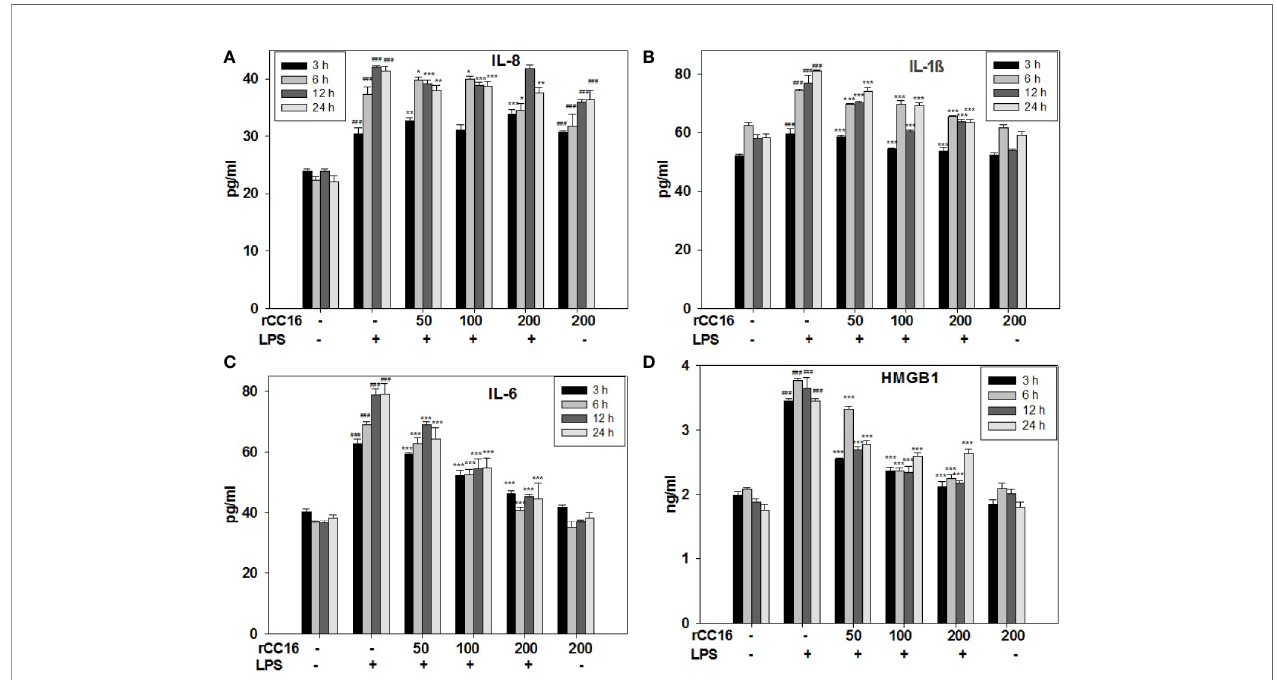
FIGURE 7 | rCC16 reversed the LPS-induced release of the in fl ammatory cytokines IL-8 (A) , IL-1 b (B) , IL-6 (C) , and HMGB1 (D) from A549 cells. A549 cells were pretreated with different concentrations of rCC16 for 12 h and then incubated with or without 200 m g/ml LPS for an additional 3, 6, 12, or 24 h. ### p < 0.001 compared with the untreated group; *p < 0.05, **p < 0.01, and ***p < 0.001 compared with the LPS group. Graphs show the mean ± SD of triplicate wells and represent three independent